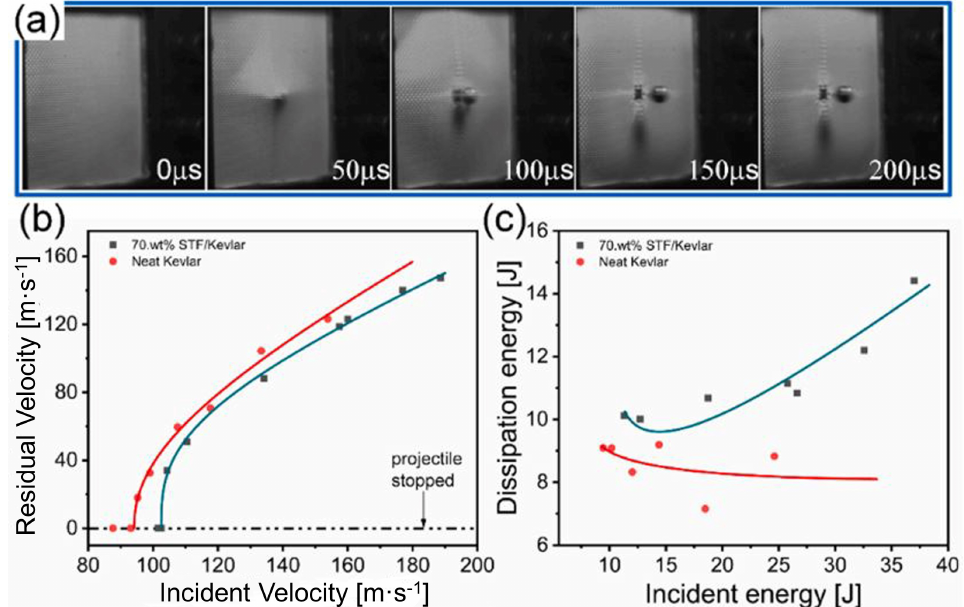
Figure 7. ( a ) The impact process diagram of neat Kevlar with different incident velocity; ( b ) the residual velocity results of STF/Kevlar and neat Kevlar; ( c ) the corresponding energy dissipation results. Reprinted with permission from Ref. [176]. Copyright 2021,